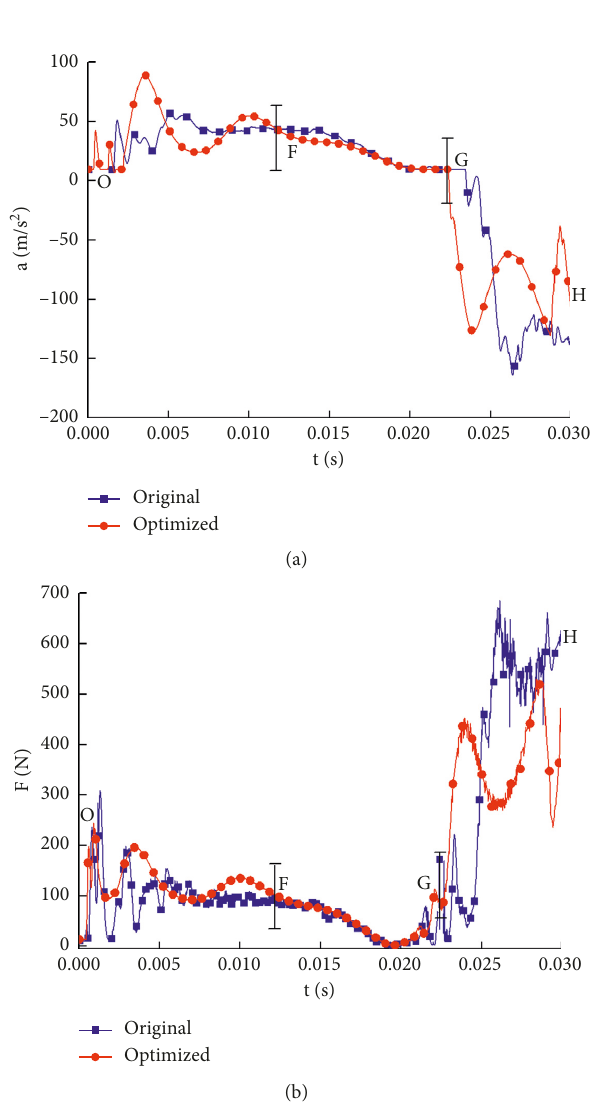
Figure 8: The optimization results of dynamic response. (a) Acceleration. (b) Reaction